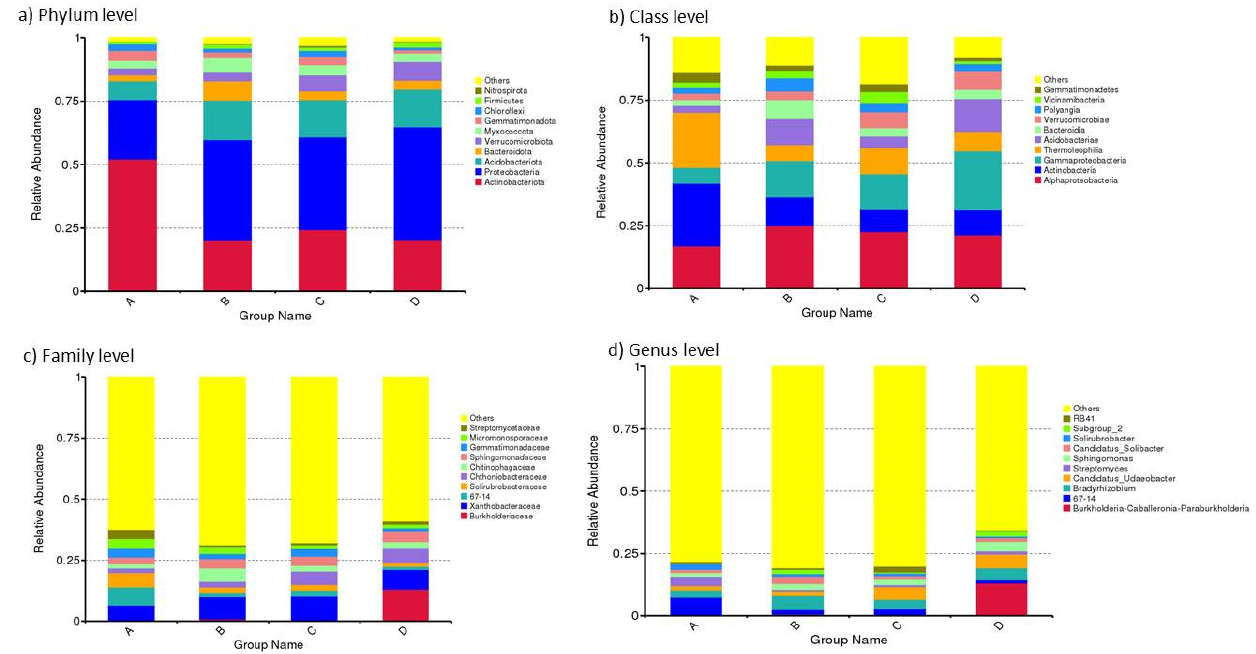
Figure 2. Relative abundance at ( a ) phylum level; ( b ) class level; ( c ) family level; ( d ) genus level of